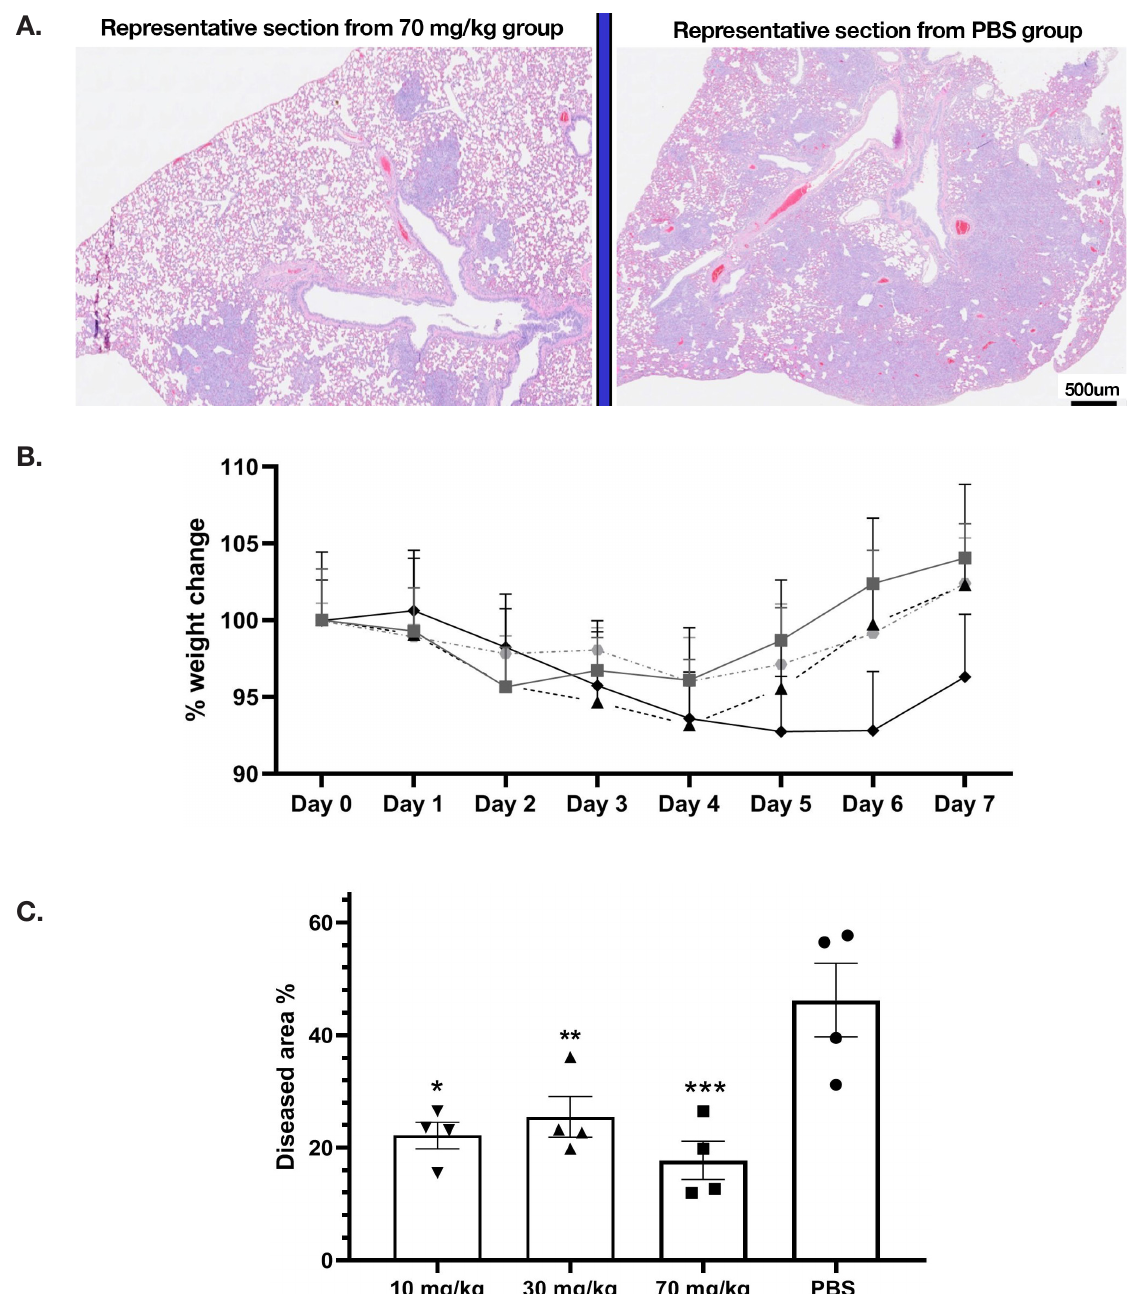
Figure 3. Golden Syrian Hamster Efficacy study. (A) Representative histopathology slides from 70 mg/kg and PBS groups after unblinding, slide scale bar is 500 µm. (B) Percent weight changes of treated compared to mock-treated golden Syrian hamster G921 efficacy study. Legend: 70 mg/kg group = rectangles, 30 mg/ kg = triangles, 10 mg/kg = circles, virus only = diamonds. Four animals were treated per group (mean +SEM). (C) Quantitation of histopathology data (mean +/- SEM), magnification assessed 1X-40X. The 10, 30, and 70 mg/kg groups demonstrate reduction of total lung inflammation relative to PBS. (Student t-test P values 10 mg/kg * 0.0132, 30 mg/kg ** 0.0317, and 70 mg/kg ***